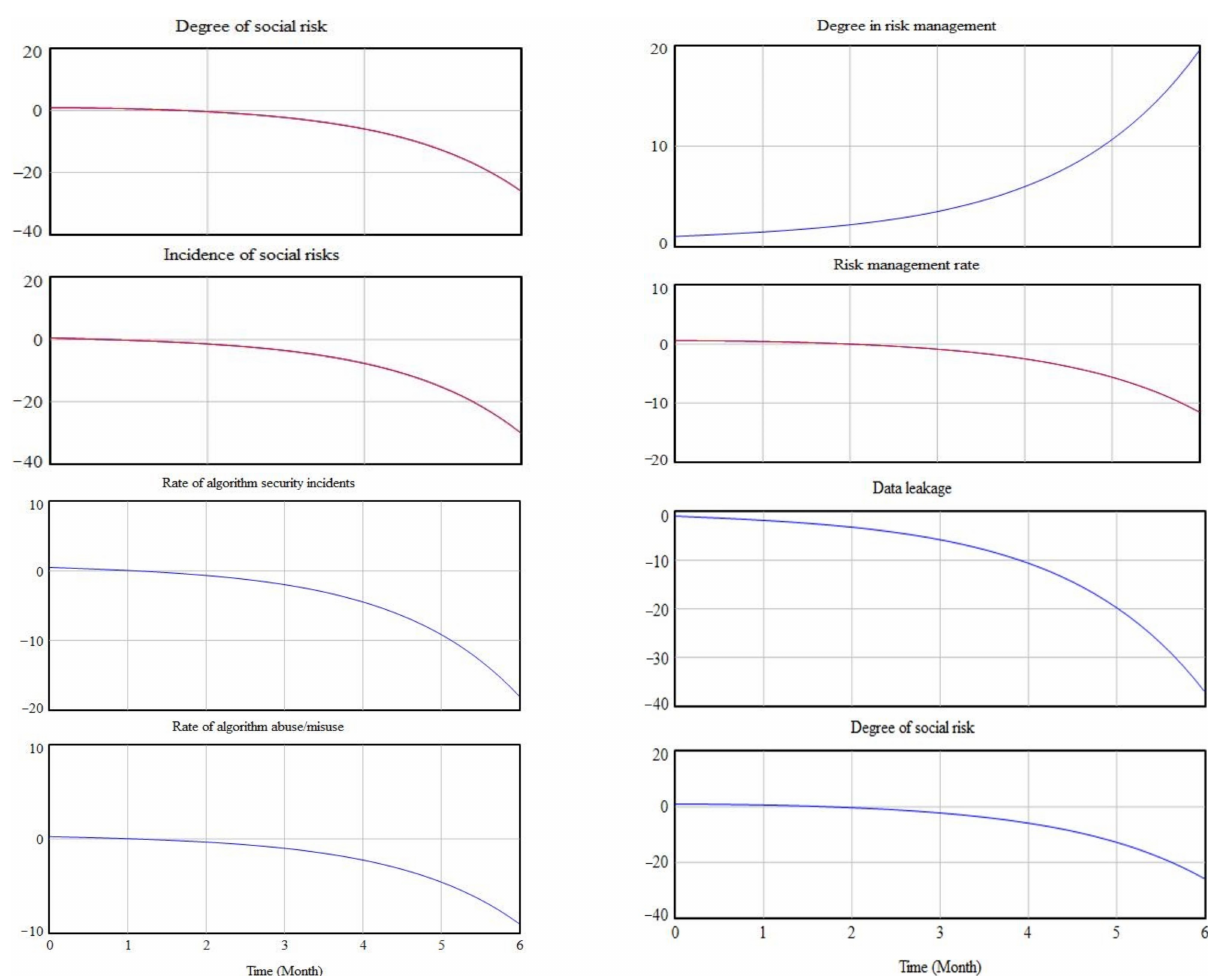
Figure 10. Risk development after